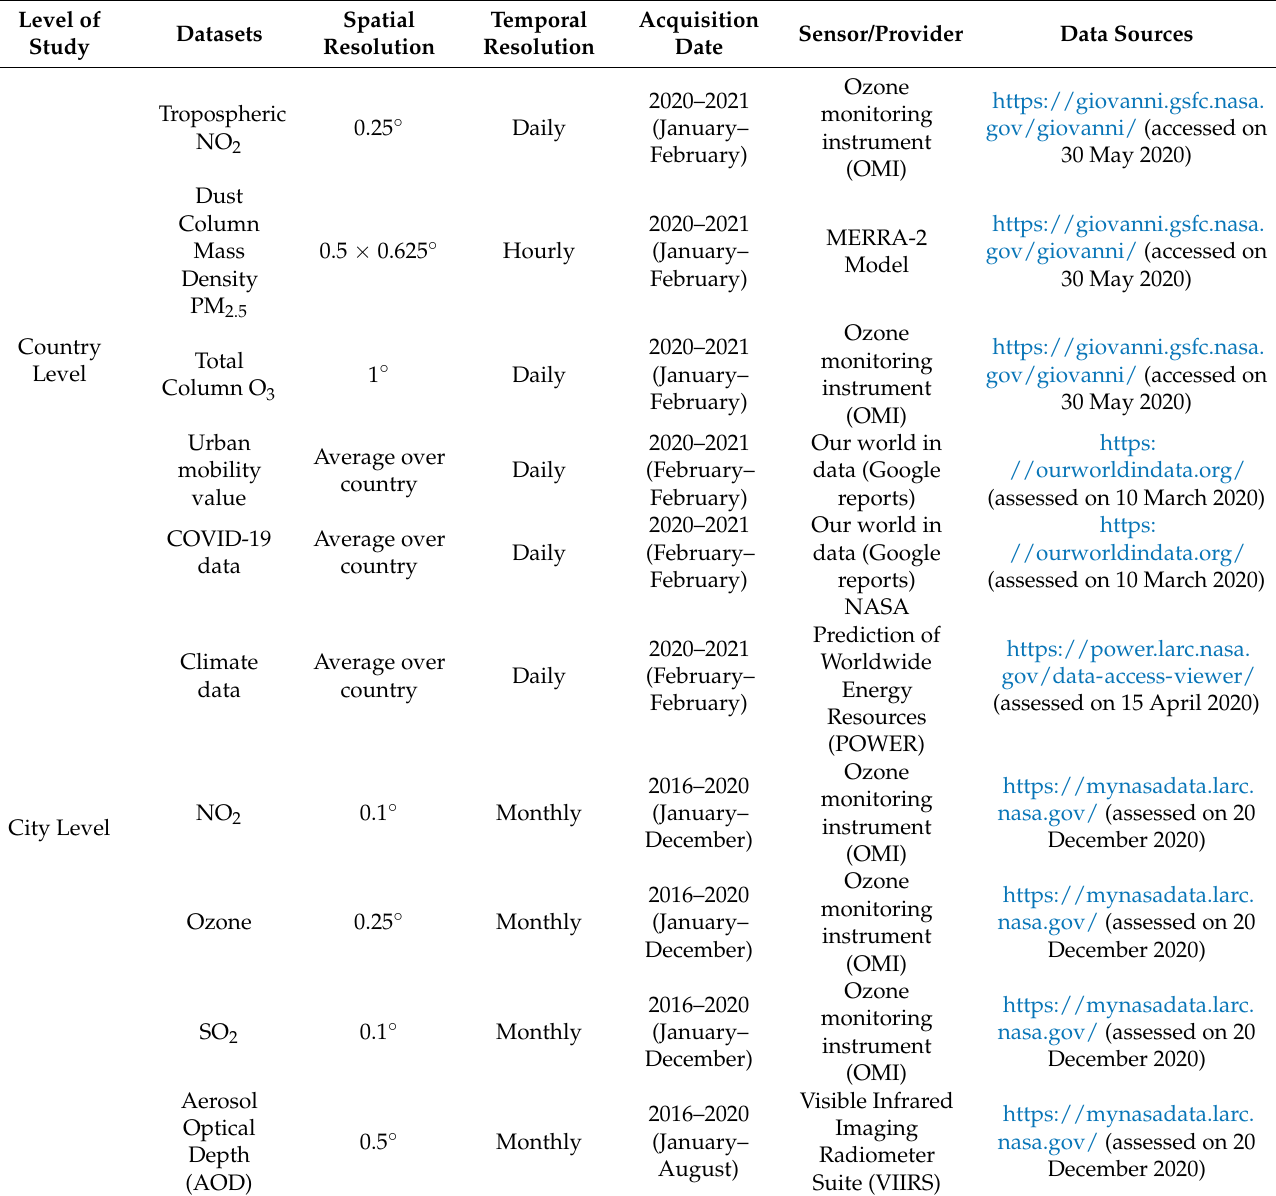
Table 2. Detail description of the datasets used in the present